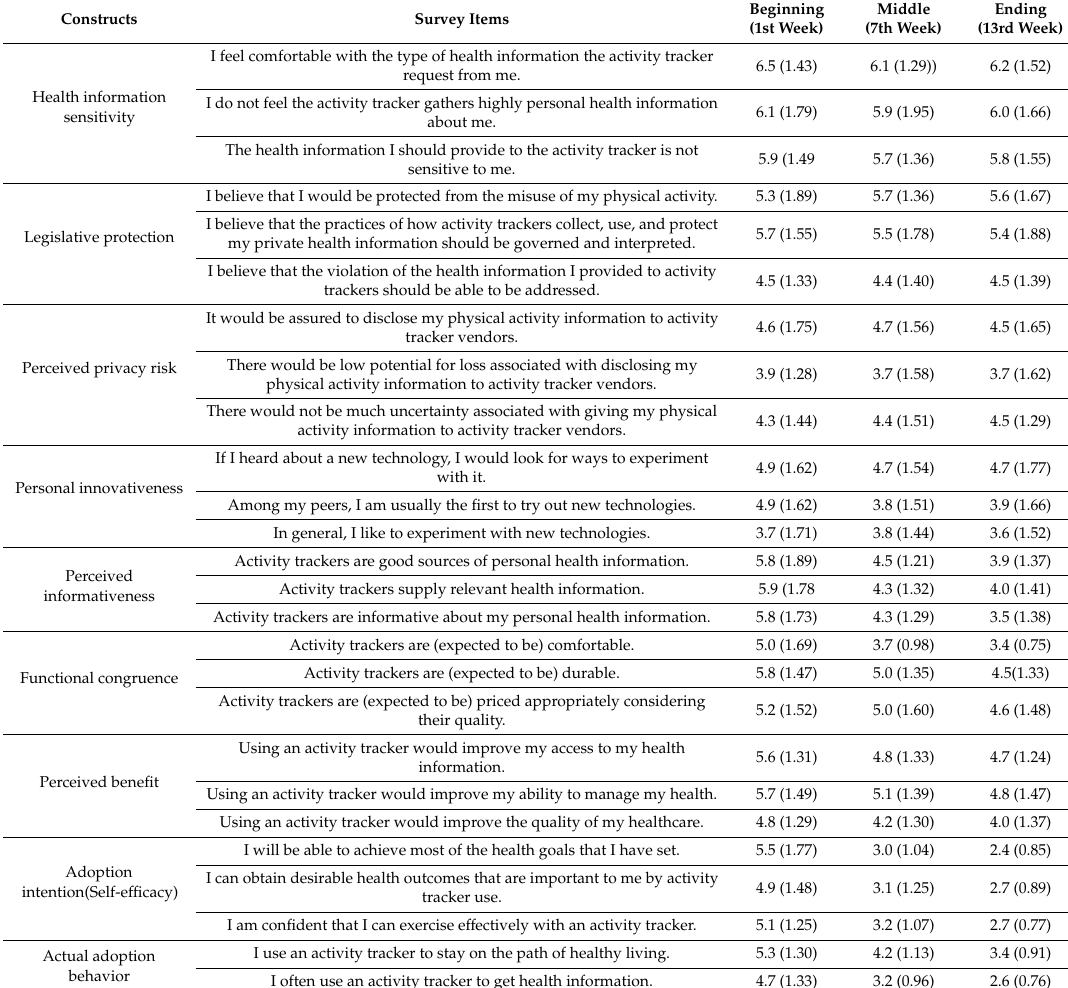
Table 2. Integrated Activity Tracker Adoption Survey Scale Results (mean